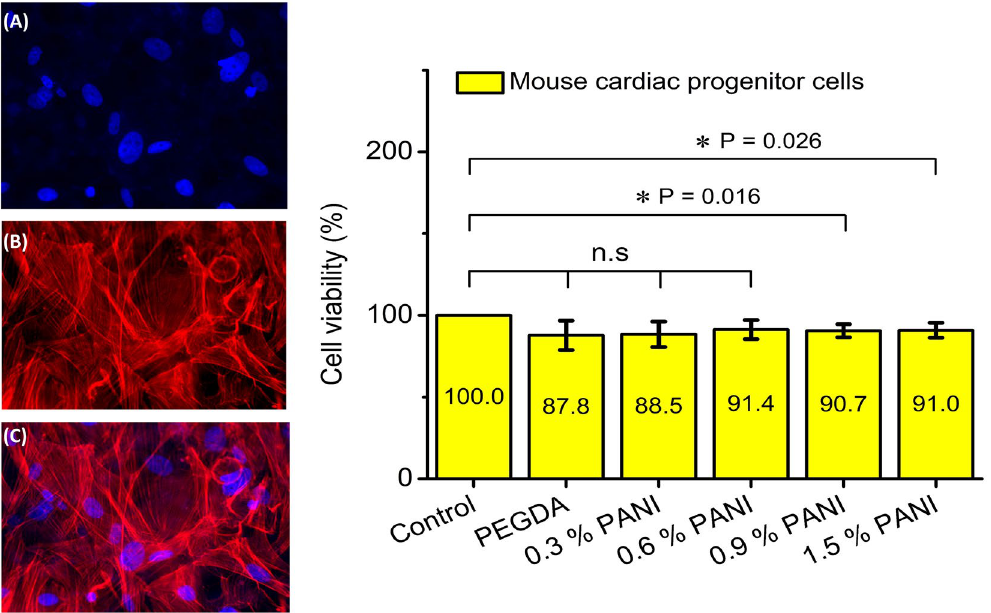
Figure 11. Viability of the mouse cardiac progenitor cells (mCPCs) on the printed scaffolds (n = 6). On the left, the representative micrographs show mCPCs stained with ( A ) DAPI (nuclei in blue), ( B ) F actin (red) and ( C ) their merge. On the top right, the cell viability was assessed via Trypan Blue assay after 5 days of culture. Bars represent the viability of the cells relative to the percentage of the control. Data are represented in Mean ± S.D of the triplicate experiments. Two tailed t-test with equal variance was performed to find out the statistical significance (* P < 0.05) between the control group (cell suspension) and the other groups (cell suspension + scaffold) while one way ANOVA between groups resulted in statistically insignificant results ( P = 0.23) showing that the mean viability was the same among all groups as can be observed by the values indicated in the bar